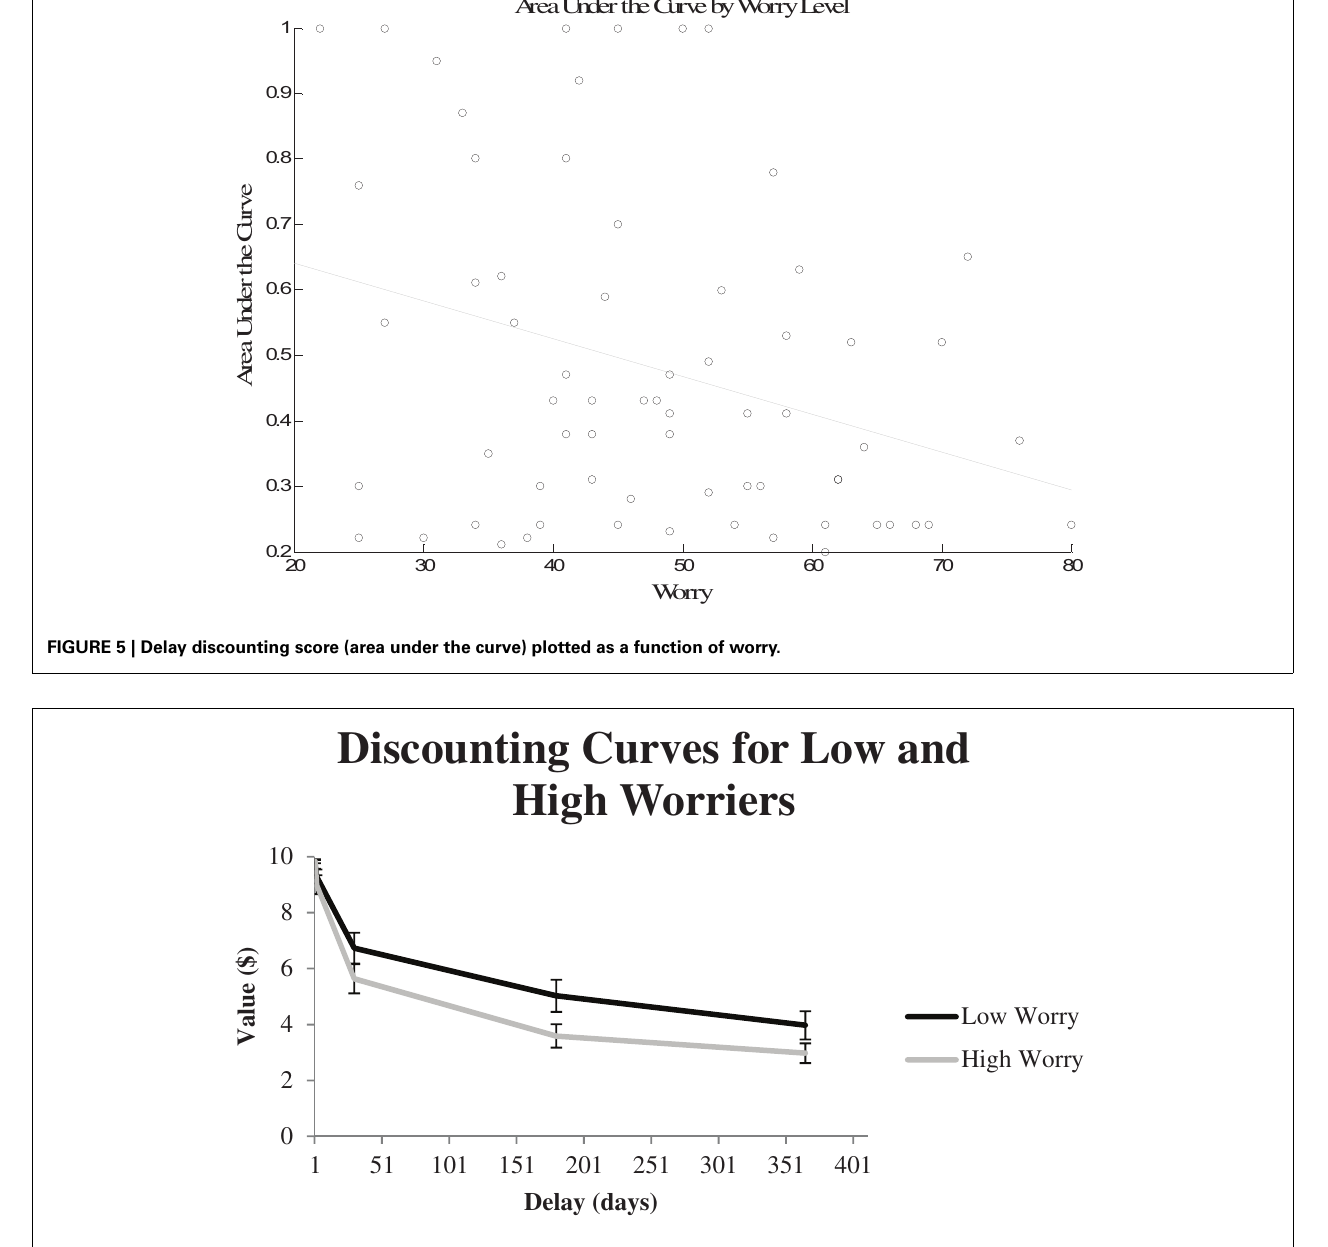
FIGURE 6 | Discounting curves for low and high worry participants for five different delays to the $10 standard value in Experiment 2. These curves represent the mean indifference values for the standard as a function of